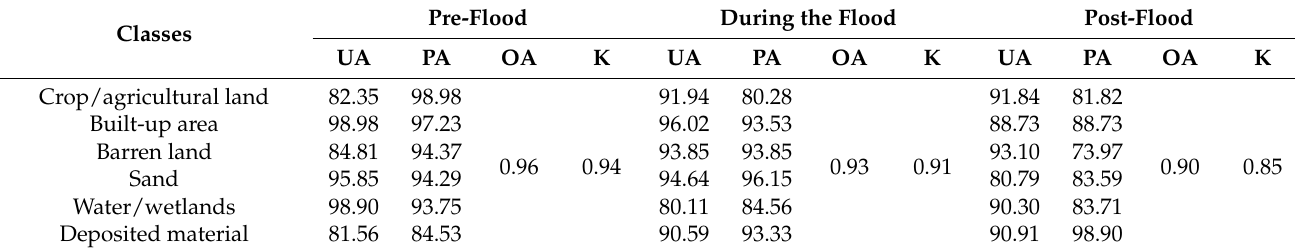
Figure 4. Change in LULC in Muzaffargarh District according to Landsat 8 images before, during, and after the 2014 flood. Different measures were used to assess the accuracy of the supervised and MLC classification to categorize the watershed into the six LULC types. The highest overall ac- curacy (OA) value, i.e., 96%, was obtained from the pre-flood image (July 22), while the post-flood image (September 24) had the lowest OA of 90%. The highest UA of the ‘built- up’ area class was attained for the pre-flood image, with a value of 98.98%, while the lowest was 80.11% for ‘water/wetland’ class for the image taken during the flood (August 8). The OA and K for Muzaffargarh District as a whole are 0.96 and 0.94 (corrected samples, 576), 0.93 and 0.91 (corrected samples, 545), 0.90 and 0.85 (corrected samples, 560) for the pre- flood, during the flood, and post-flood image, respectively (Table 3). Table 3. Accuracy assessment (%) of the LULC before, during, and after the 2014